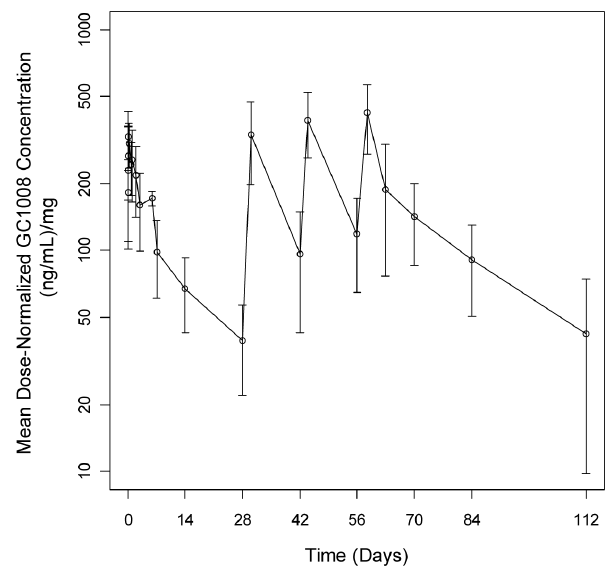
Figure 5. Pharmacokinetics. GC1008 levels were measured from blood samples collected on days 0, 1, 3, 7, 14, 28, 42, 56, 63, 70, 84, 112, 140 and every three months during follow up. Mean dose-normalized GC1008 concentrations (mean 6 standard deviation) were determined. Pharmacokinetic data for all patients through the first 4 doses of treatment are represented in this plot. Concentrations are normalized to the administered dose, and no intrapatient dose escalations are included. Accumulation of the antibody was # 2.5-fold at the C min and , 1.6-fold at C max . When all pharmacokinetic data is examined, including that from patients receiving Extended Treatment, GC1008 demonstrated an overall calculated half-life of 21.7 days.